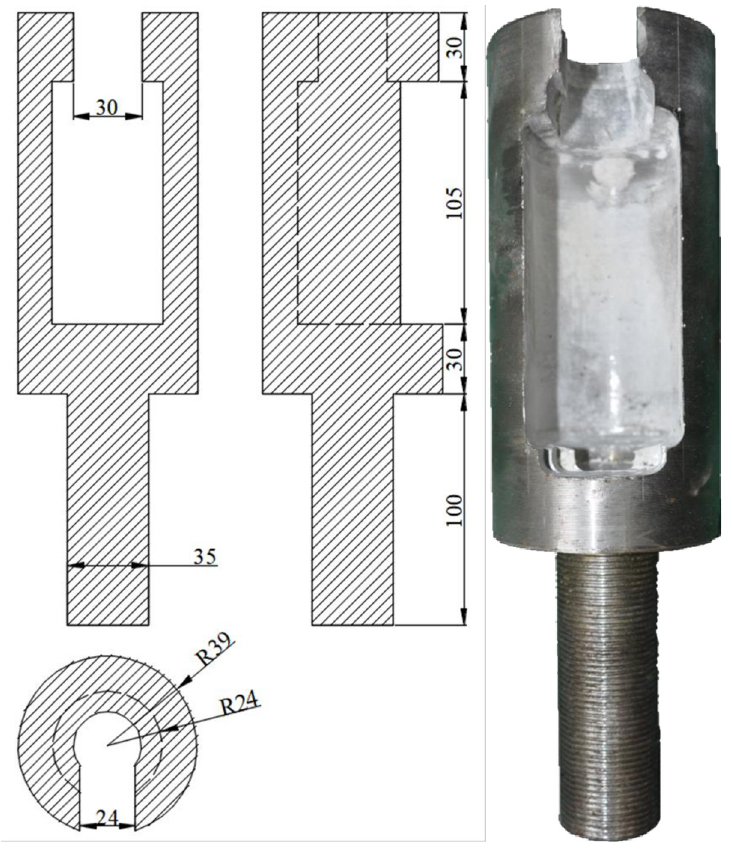
Fig 8. Pullout specimen holding device (unit: